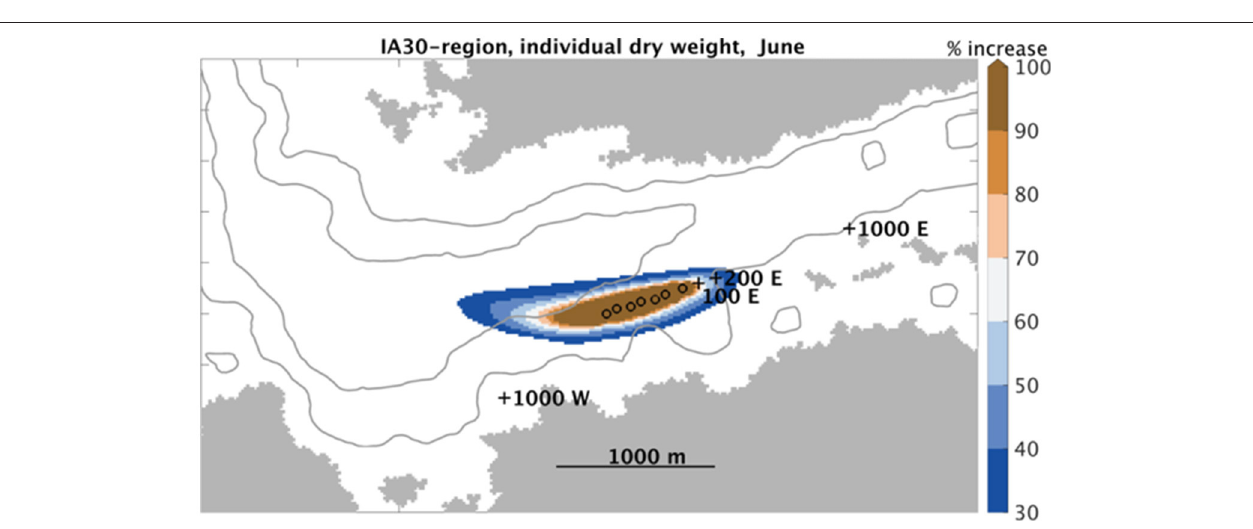
FIGURE 6 | IA 30 for dry weight. Spatial extent of the region with a 30% (or greater) increase in individual sporophyte dry weight yields from a simulation scenario without to one with salmon farm effluents. Each model grid cell represents an area of 32m × 32m. IA 30 = 27 ha in this case.